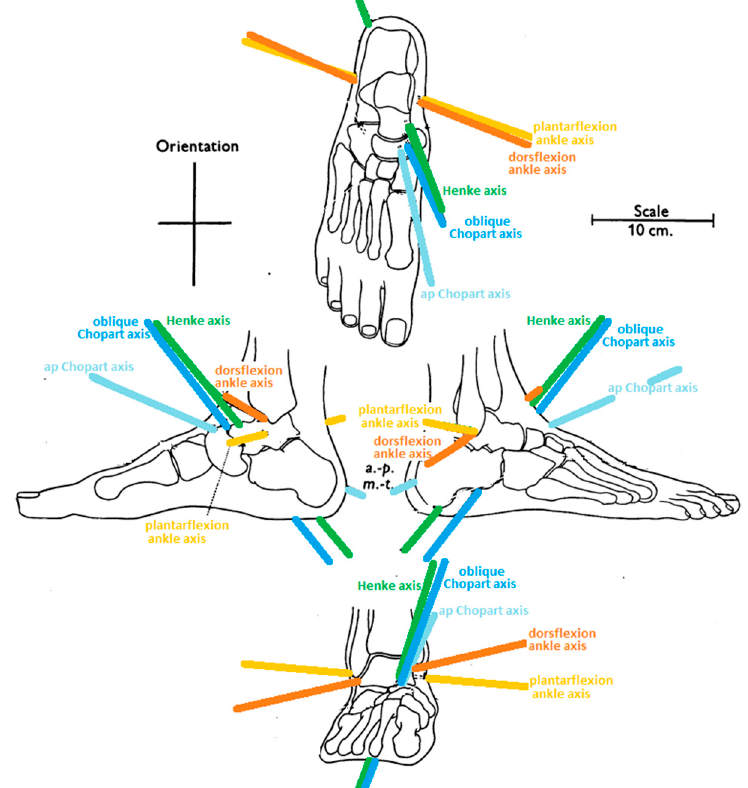
Figure 4. The axes of the joints of the foot: dorsiflexion upper ankle axis; plantar flexion upper ankle axis; Henke axis (lower ankle axis, talocalcaneonavicular axis); oblique Chopart axis (oblique mid-tarsal axis); ap Chopart axis (antero-posterior mid-tarsal axis; longitudinal axis). Own elaboration based on a drawing from [15]. Table 1. The value of the arm of force is expressed in centimeters. It is measured from the axis of rotation of a given joint to the pulling of a given muscle (the shortest distance). The symbols {+} and { − } indicate the position of the tendon in relation to the joint axis. The upper ankle joint: {+} behind, { − } in front; the lower ankle joint (Henke axis): {+} medially, { − } laterally; Chopart joint (longitudinal axis): {+} medially, { − } laterally. Zero {0} means that the pulling of muscle runs paral- lel to the joint’s axis of rotation. Lack of data {---} means that the pulling muscle does not cross the axis of the joint and therefore does not affect the joint. Table based on Hicks’ data [12]. Muscle